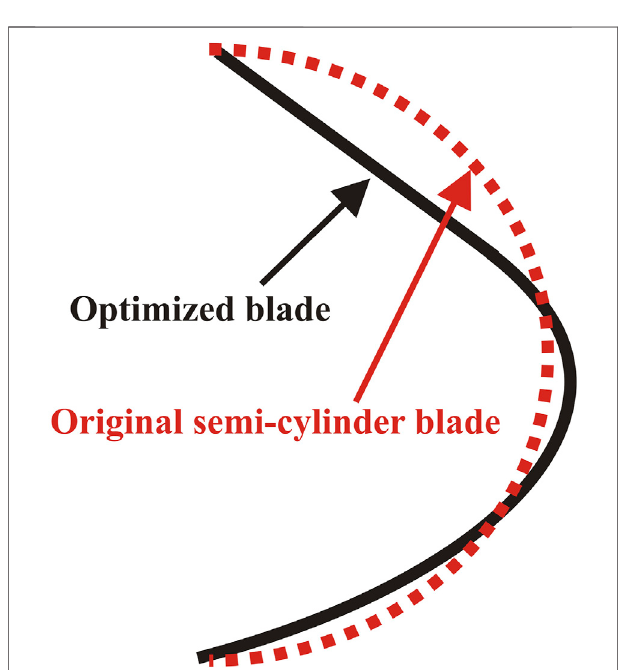
FIGURE 6 | Optimal con fi guration compared to the original turbine (semi-cylindrical shape).